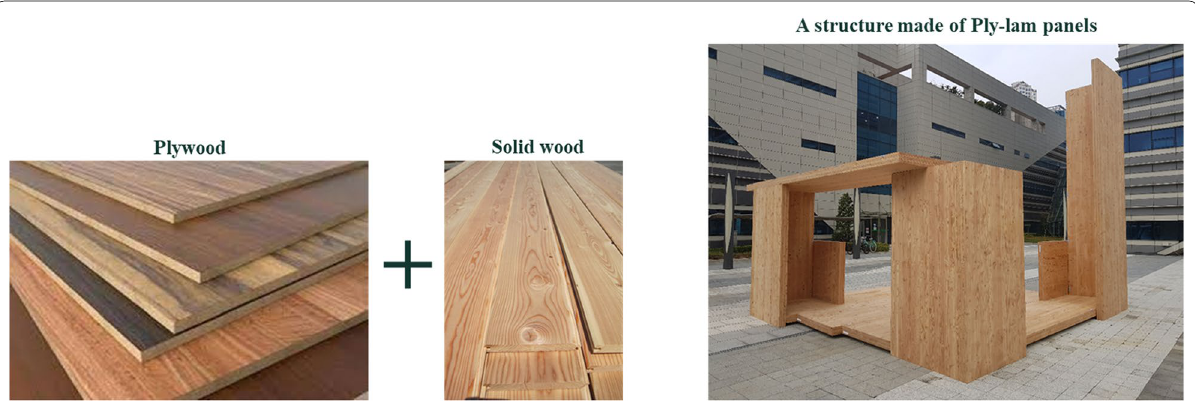
Fig. 1 Pavilion structure constructed with Ply‑lam panels made of plywood and solid wood